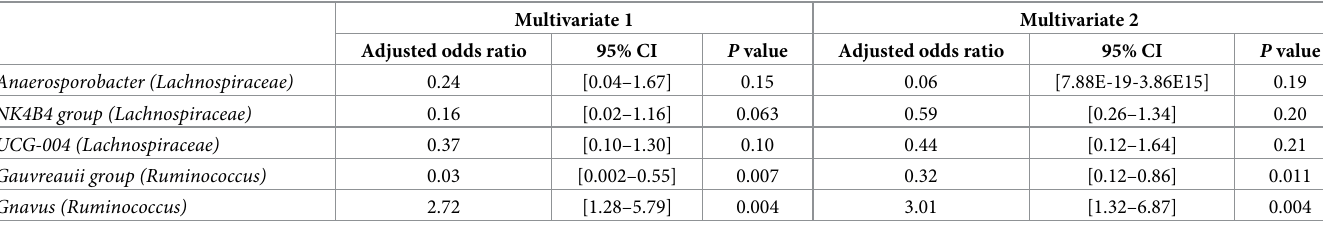
Table 4. Multivariate logistic regression analysis to predict the development of